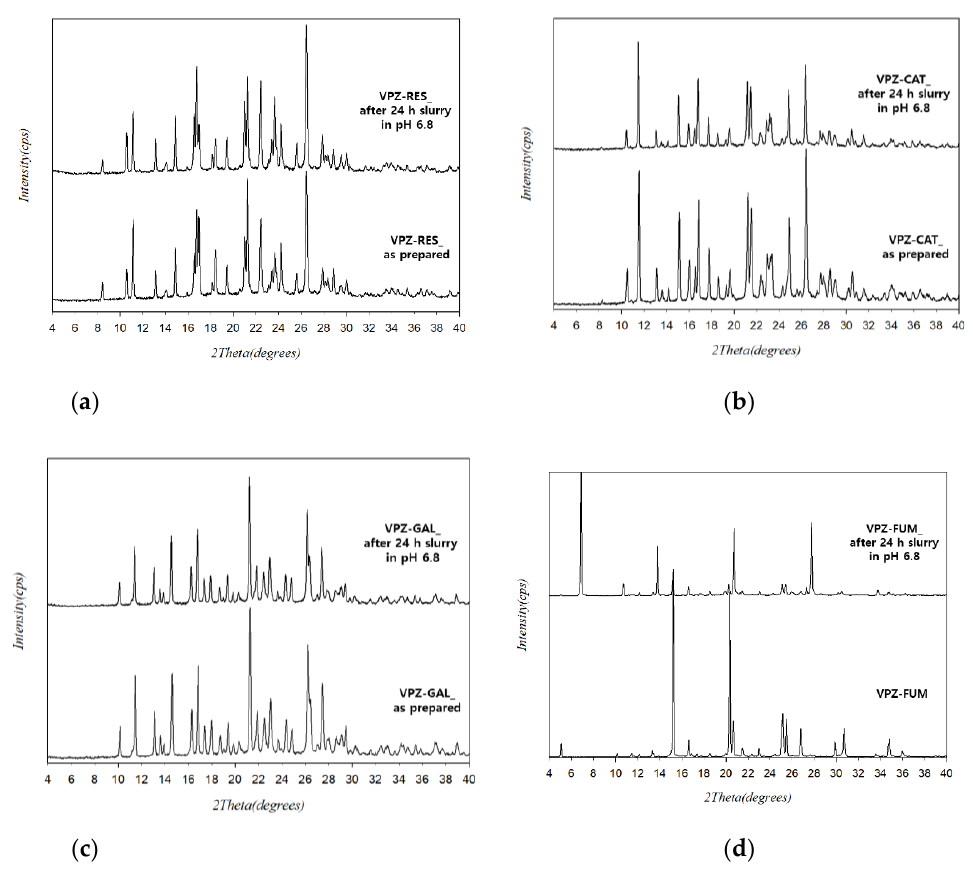
Figure 6. Comparison of the PXRD patterns of ( a ) VPZ-RES, ( b ) VPZ-CAT, ( c ) VPZ-GAL, and ( d ) VPZ fumarate after 24 h slurry.